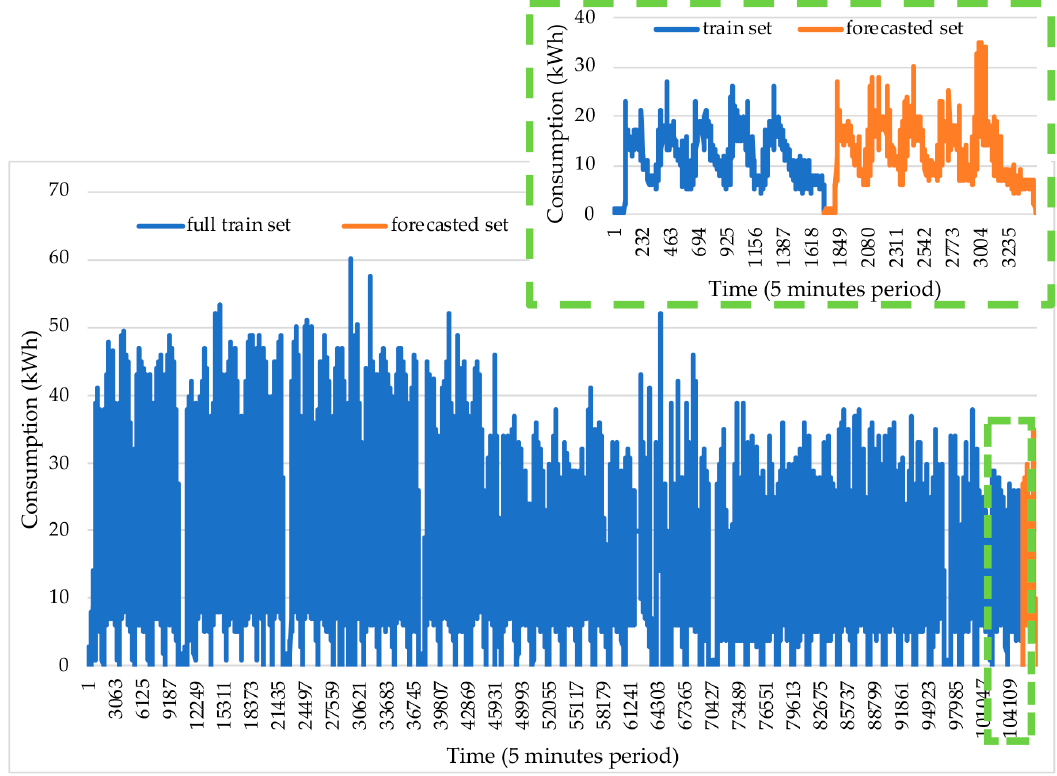
Figure 6. Consumption monitored with a one-week test, measured from 8 to 13 April 2019, and the historical time period of the 61 weeks preceding 8 April 2019.